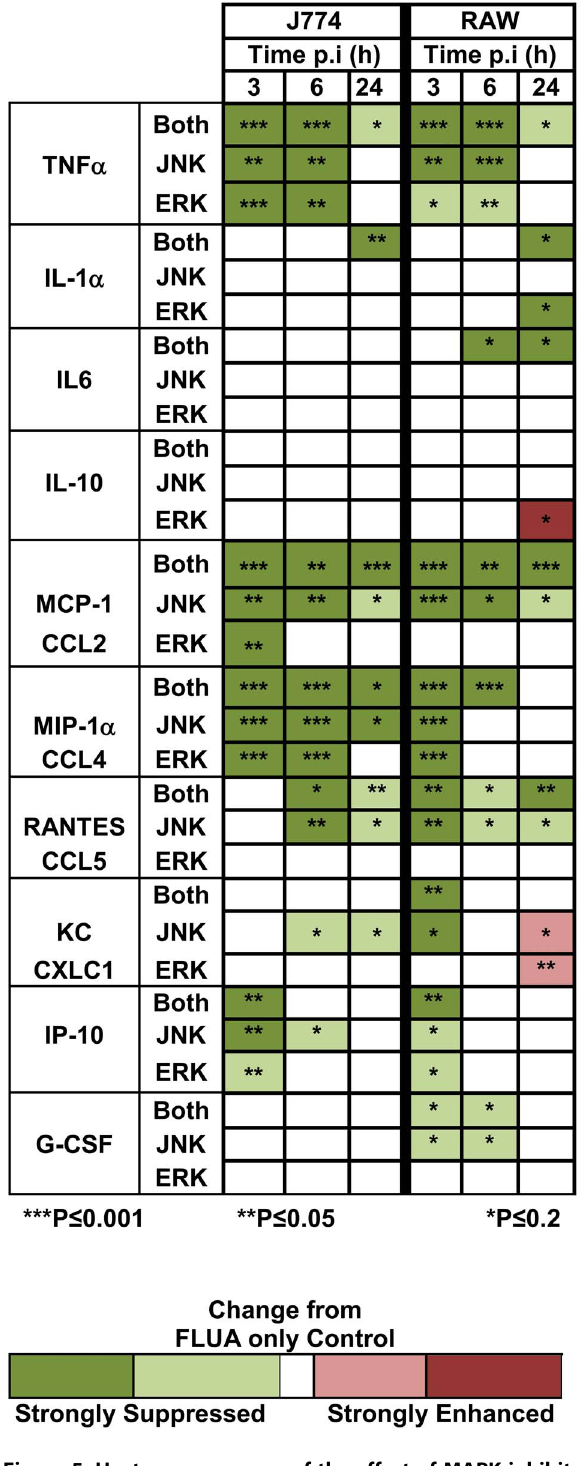
Figure 5. Heat map summary of the effect of MAPK inhibitors on FLUA-induced CK/CHKs. Supernatants from cells pre-treated with the indicated inhibitors for 1 h then exposed to FLUA were collected 3, 6, or 24 h after exposure, along with those from mock infected controls. They were assayed for selected CK/CHK by multiplexed fluid phased antibody based analysis. Cytokine concentra- tions were calculated based on known concentration standards run at the same time. CK/CHKs are arranged by family, TNF, interleukins, CCL, CXCL, and growth factors and then in numerical order. Colors are